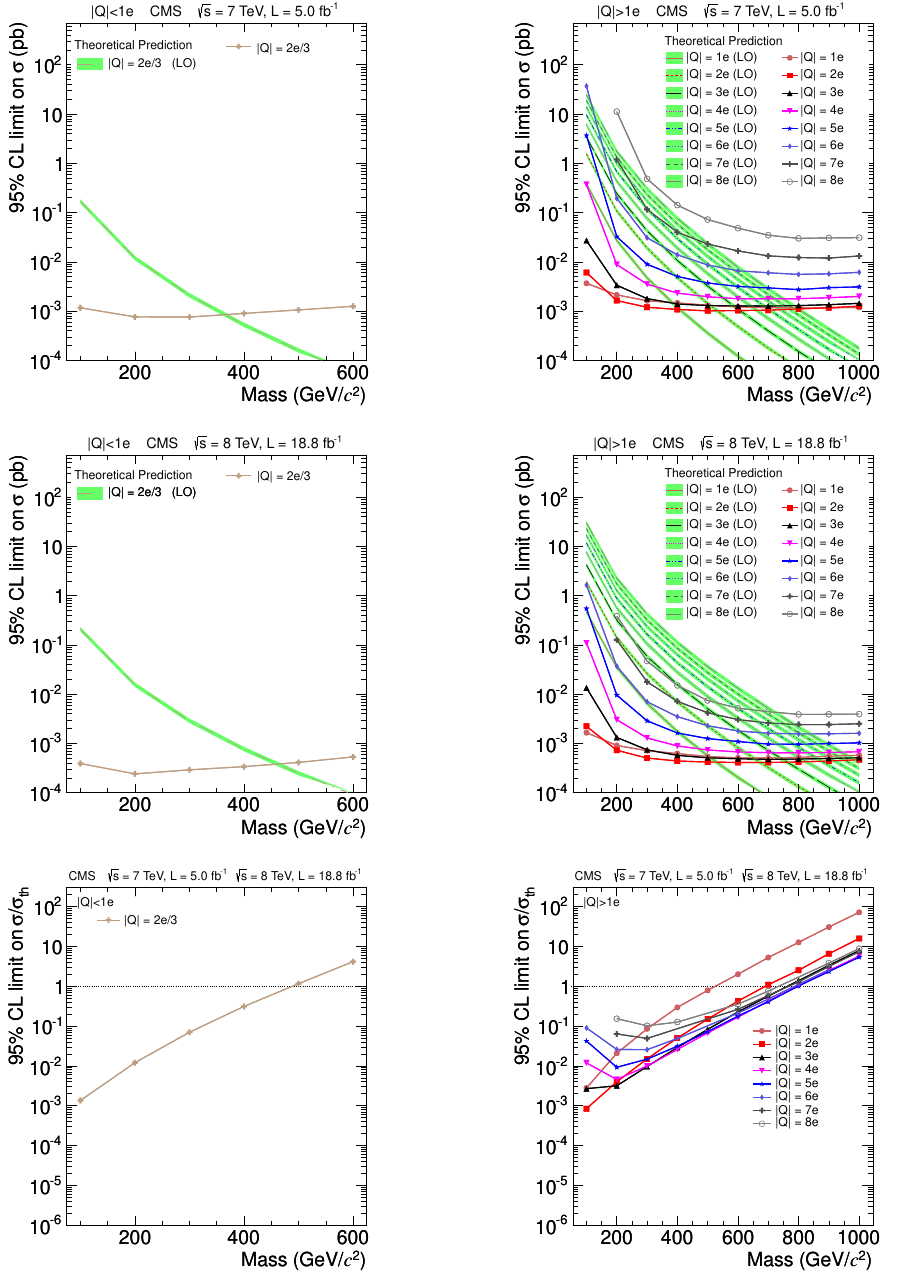
Figure 10 . Upper cross section limits at 95% C.L. on various signal models for the fractionally charged analysis (left column) and multiply charged analysis (right column). The top row is for the √ √ data at s = 7 TeV, the middle row is for the data at s = 8 TeV, the bottom row shows the ratio of the limit to the theoretical value for the combined